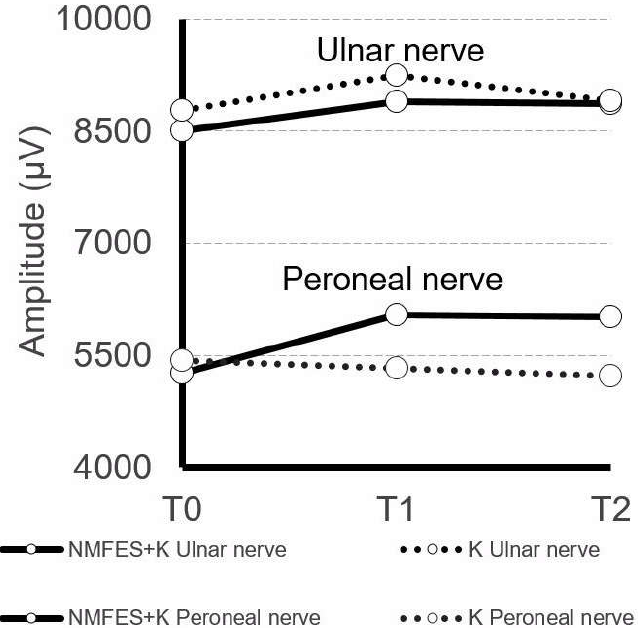
Figure 6. Summary of the neurophysiological results recorded in two groups of patients at three stages of